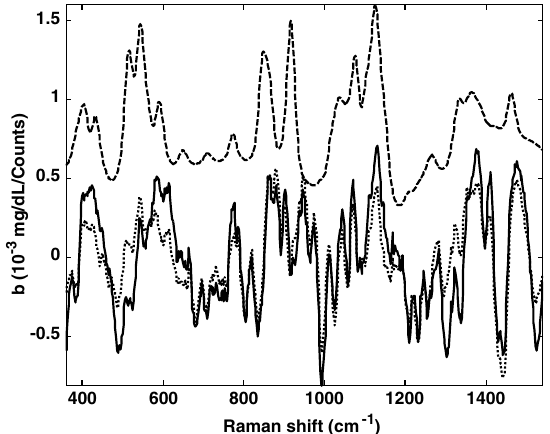
Fig. 3. Comparison of the glucose spectrum (dashed line) with the smoothed PLS b vector (dotted line) and CR b vector (solid line) for data from one